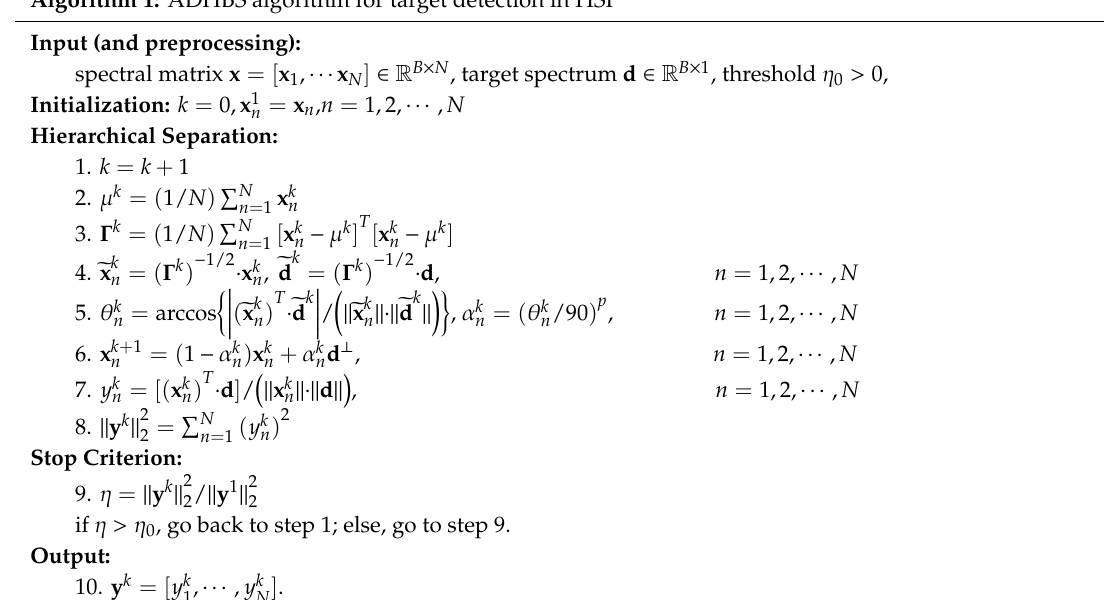
Algorithm1 ADHBS algorithm for target detection in HSI